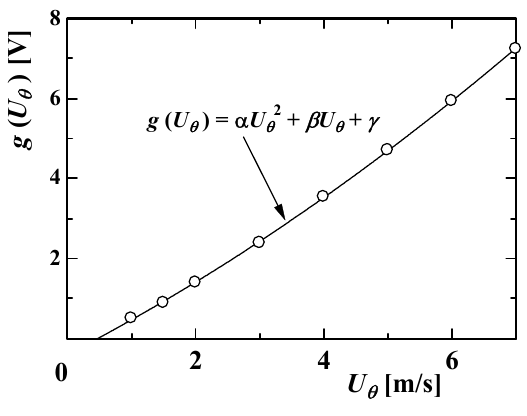
Fig. 12 Calibration curve of g ( U θ ) versus U θ